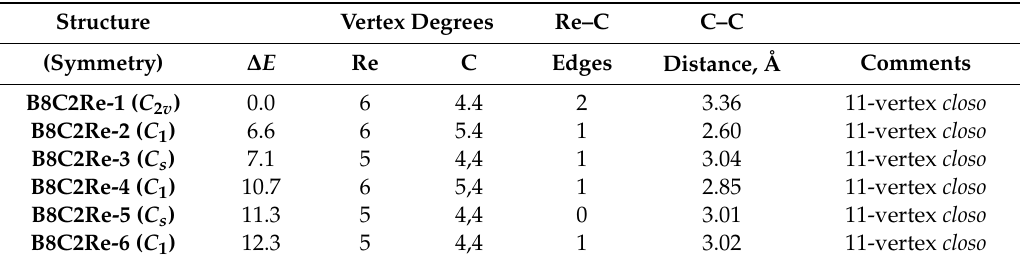
Figure 6. The six optimized lowest energy 11-vertex C 2 B 8 H 10 Re(CO) 2 (NO) structures. Table 4. The six optimized 11-vertex C 2 B 8 H 10 Re(CO) 2 (NO) structures within 15 kcal / mol of the lowest energy structure.